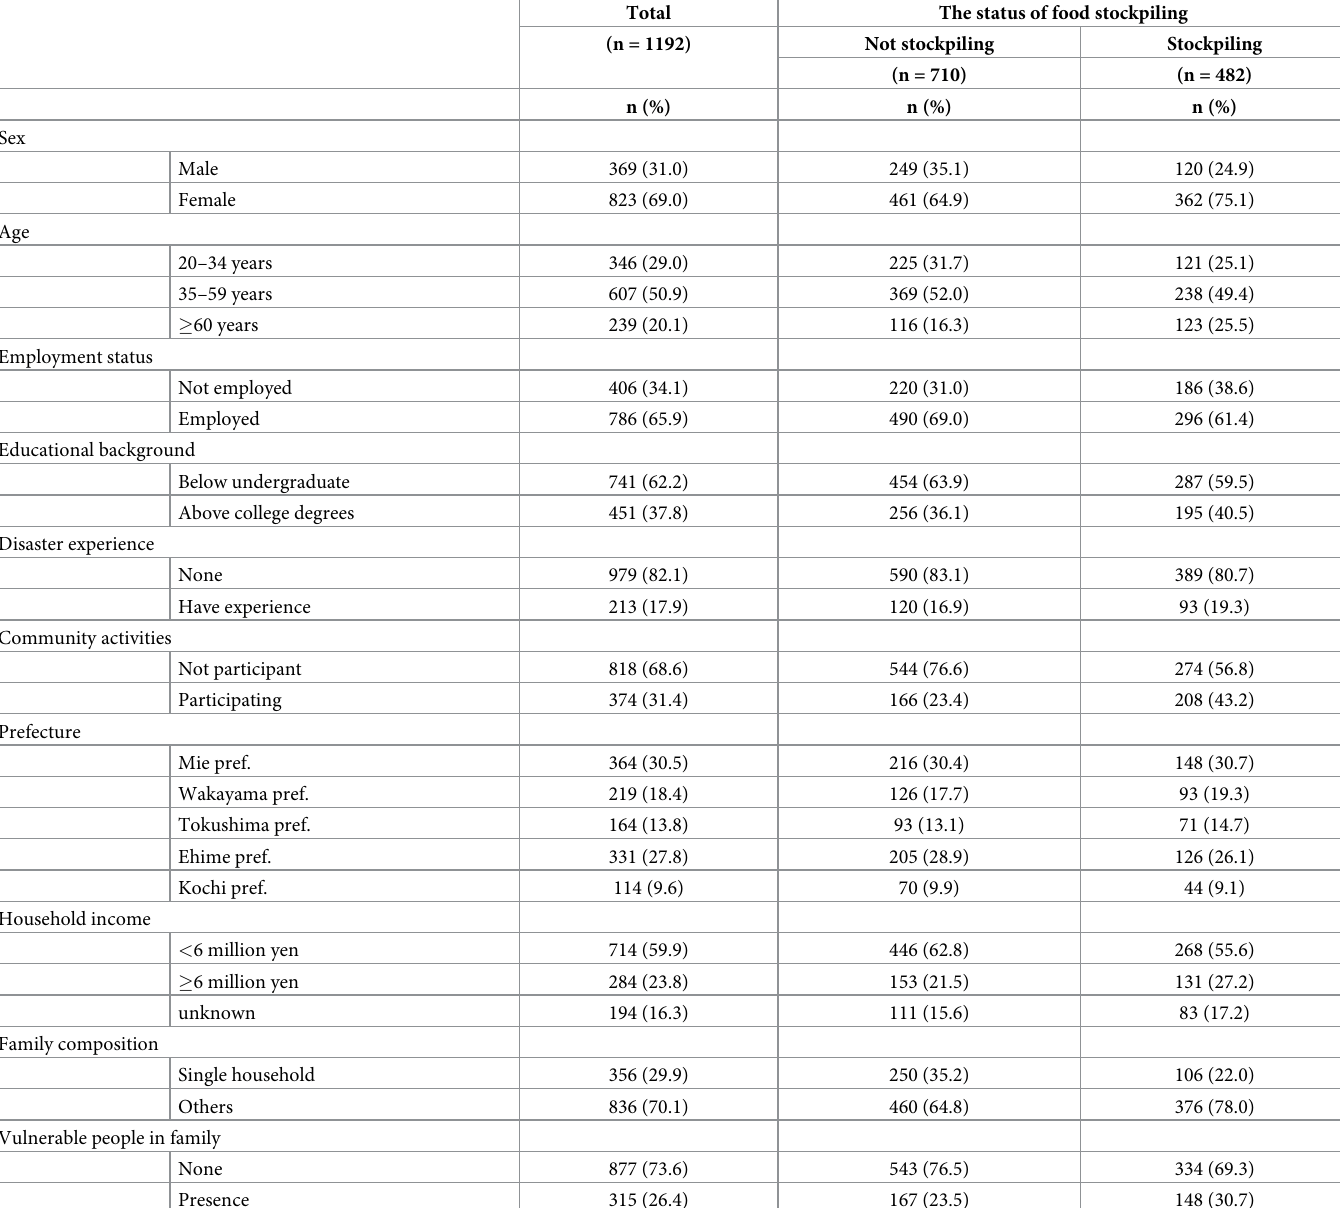
Table 1. Participants’ characteristics distinguished by the status of stockpiling disaster